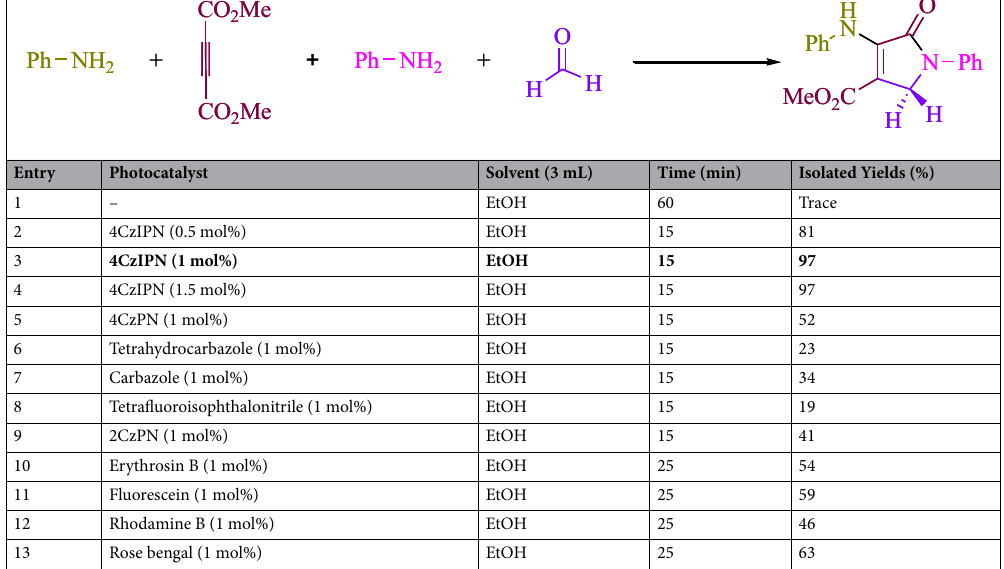
Table 1. We provide an optimization table for photocatalysts used in 5a production a . Significant values are in [bold]. a Reaction conditions: a blue LED (7 W) is used along with a number of photocatalysts and